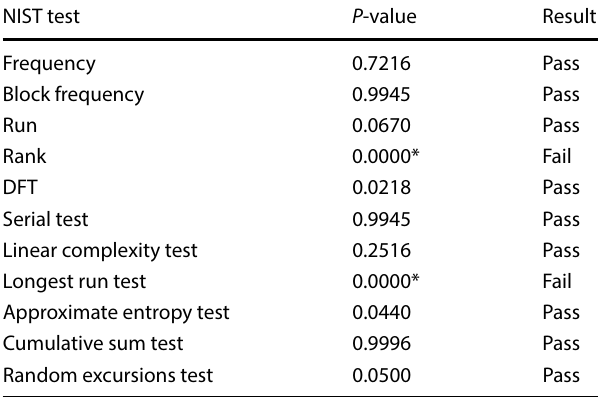
Table 7 NIST statistical test results for TRNG (FAT-2)